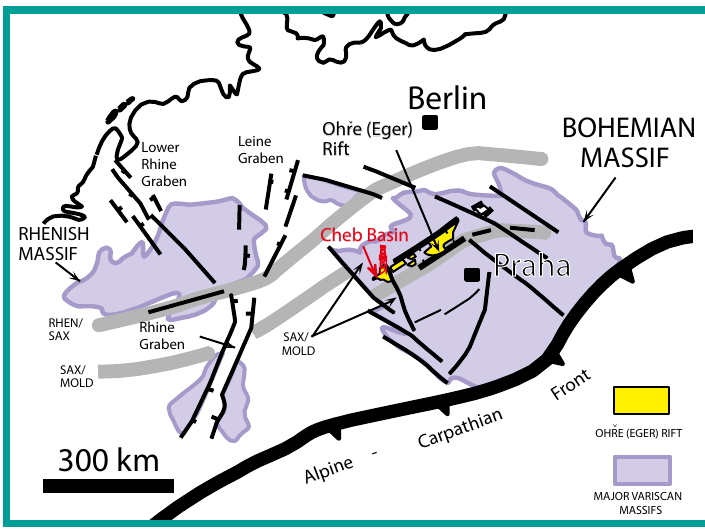
Figure 1. The Eger Rift as part of the European Cenozoic Rift System. Suggested location for drilling is